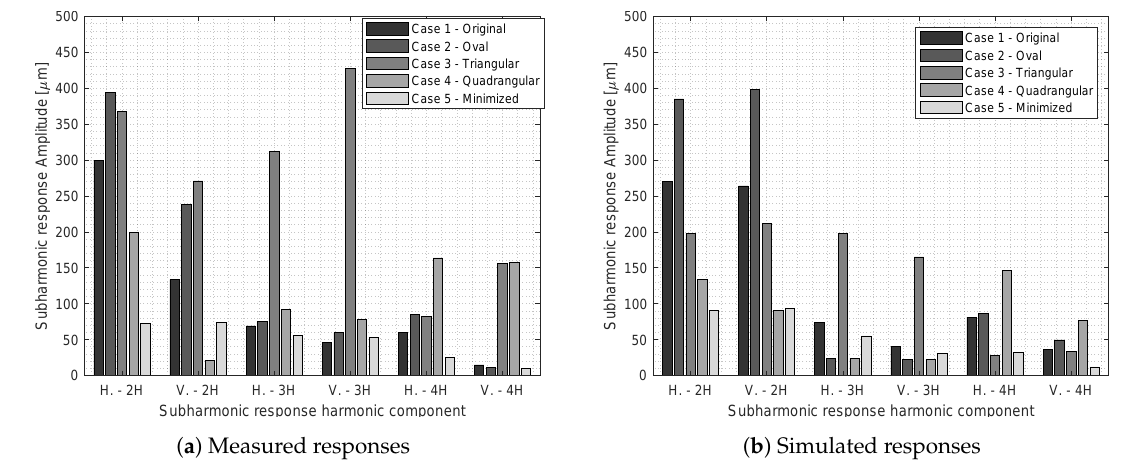
Figure 17. Measured and simulated harmonic component responses in horizontal (H.) and vertical (V.) directions in the studied cases 1 to